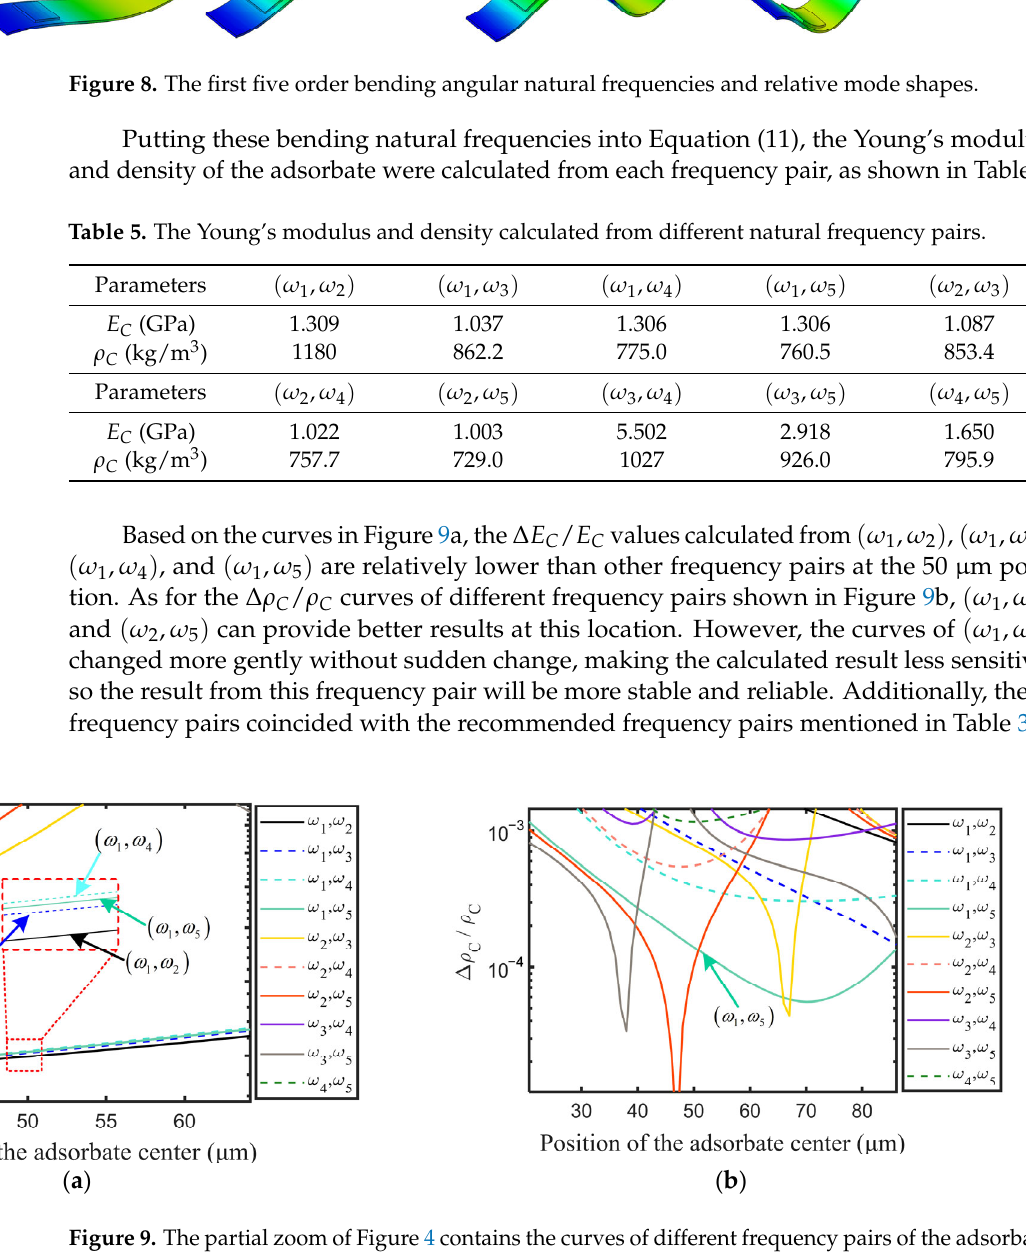
C E ‐ C  curves of the first five order natural frequencies and the recommended fre ‐ quency pairs to calculate the Young’s modulus and density values of the adsorbate. 5. Conclusions In summary, a mathematical model based on the Rayleigh–Ritz method was built to determine the Young’s modulus and density of an adsorbate by measuring several verti ‐ cal vibration natural frequencies of the resonator and extracting the intersections of their nonlinear Young’s modulus and density curves. Ideally, the intersections of different nat ‐ ural frequency curves would coincide, which revealed the Young’s modulus and density of the adsorbate simultaneously. This research revealed a vital conclusion, that when there were errors in the measurement of natural frequencies, the position of the adsorbate had a complicated and nonlinear effect on the measurement accuracy of Young’s modulus and density. Furthermore, this study revealed that frequency pairs and the relative position of the adsorbate on the cantilever are two important factors that affect the accuracy and re ‐ liability of the measurement. Using appropriate frequency pairs can improve the accuracy and reliability of measurement. This study provided a method to set the adsorbate at